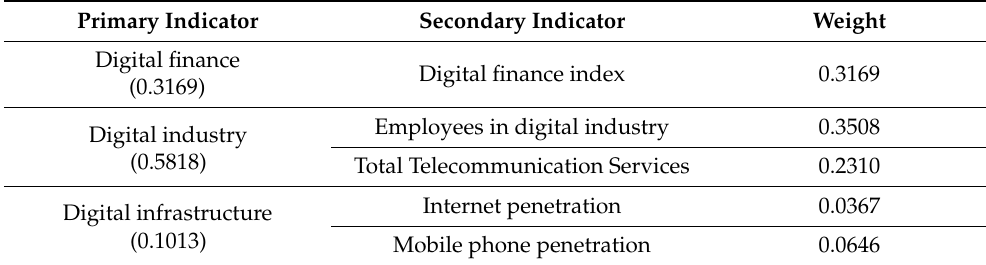
Table 1. Digital economy indicator